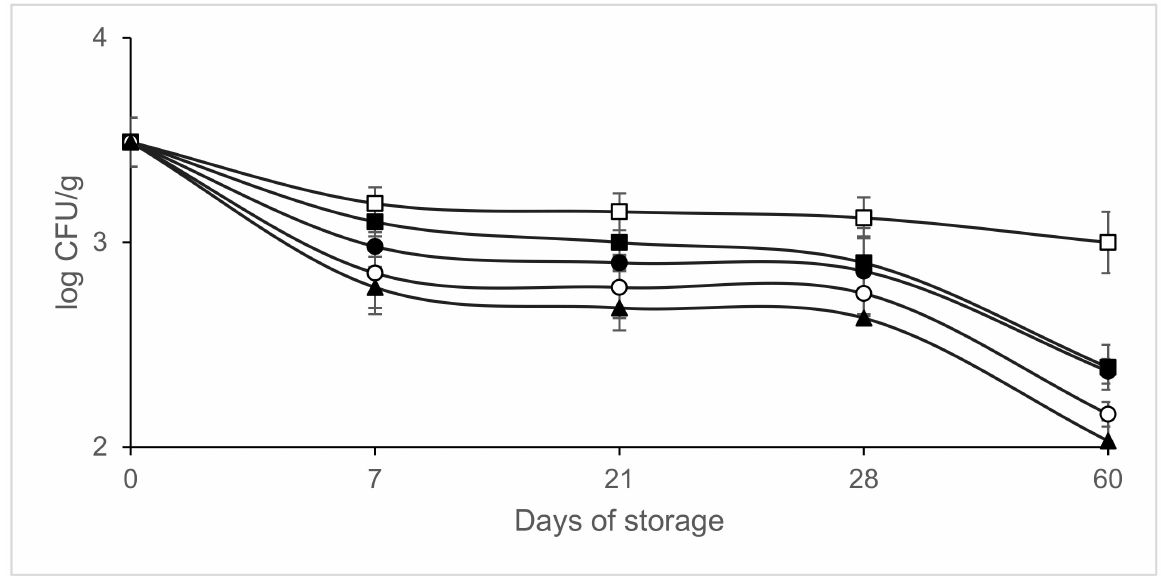
), 40% CO 2 /60% N 2 ( (cid:78) ). (cid:35)